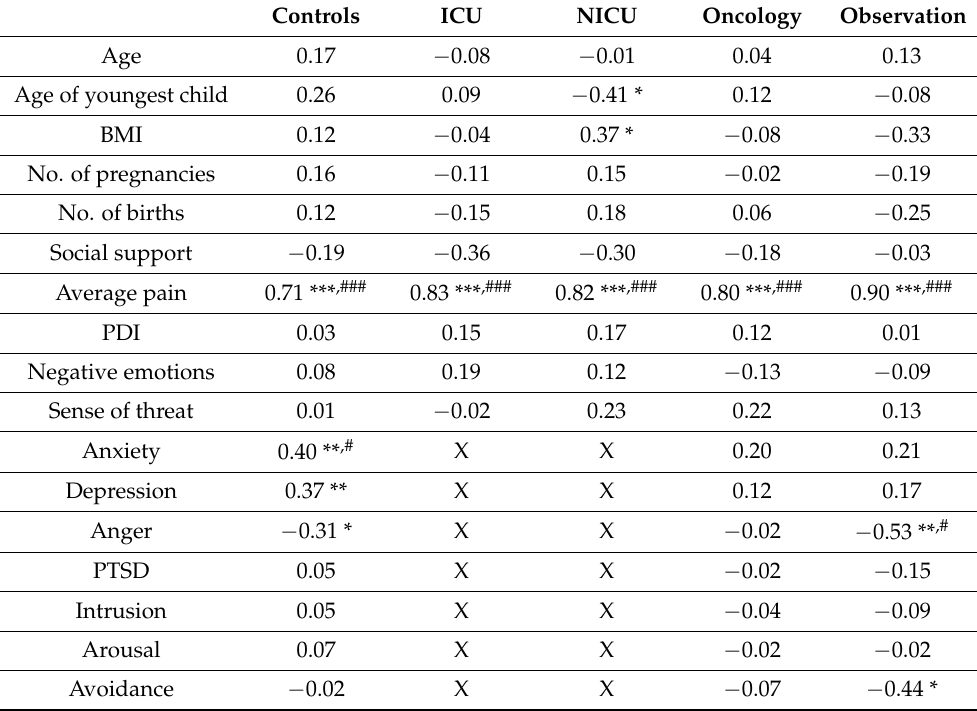
Table 8. Correlations between the intensity of maximum pain and selected demographic, medical, and psychological variables (Spearman’s